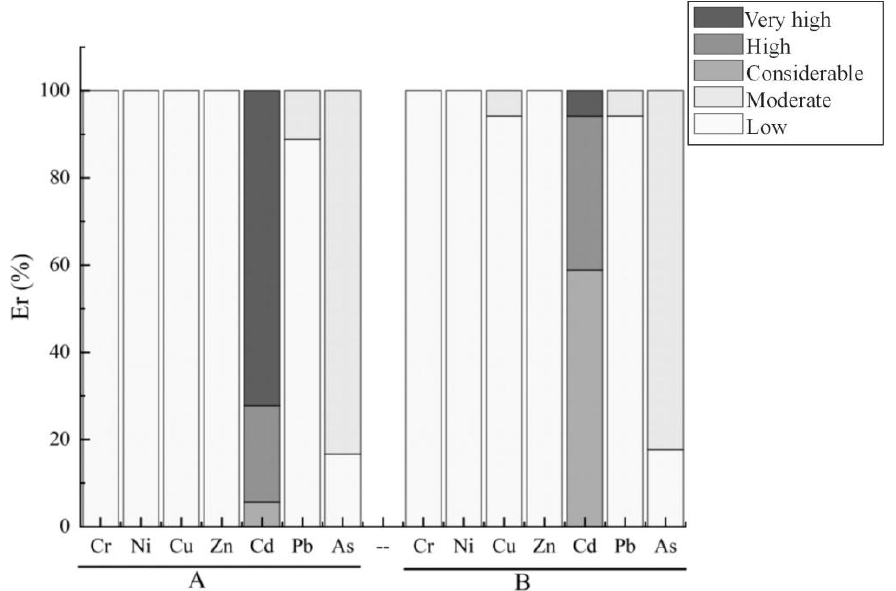
Figure 4. Distribution results of heavy metals in soil according to the single factor potential ecological risk index. A—Smeltery A; B—Smeltery B.